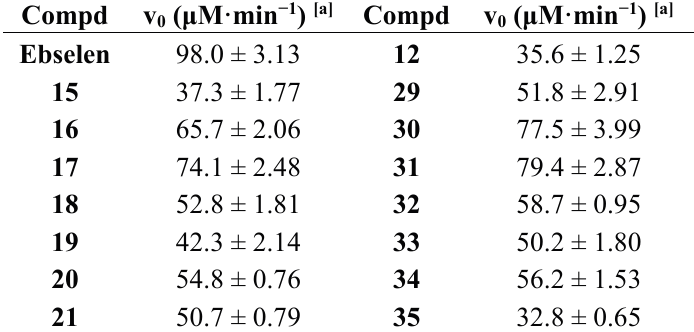
Table 1. Initial rates for the reduction of H 2 O 2 in the presence of catalysts ebselen , 12 , 15 – 21 and 29 – 35